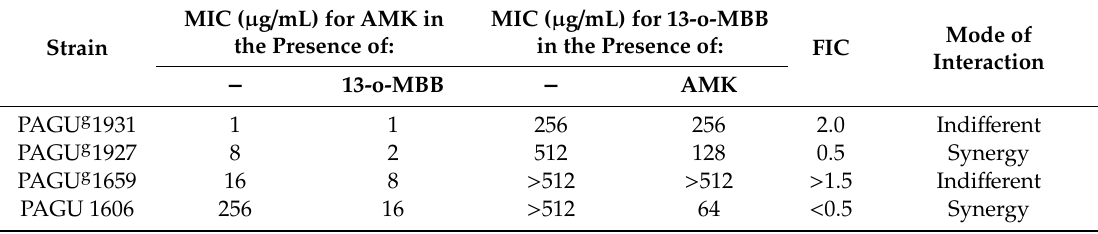
Table 6. Antibacterial activities of berberine derivatives against P. aeruginosa.